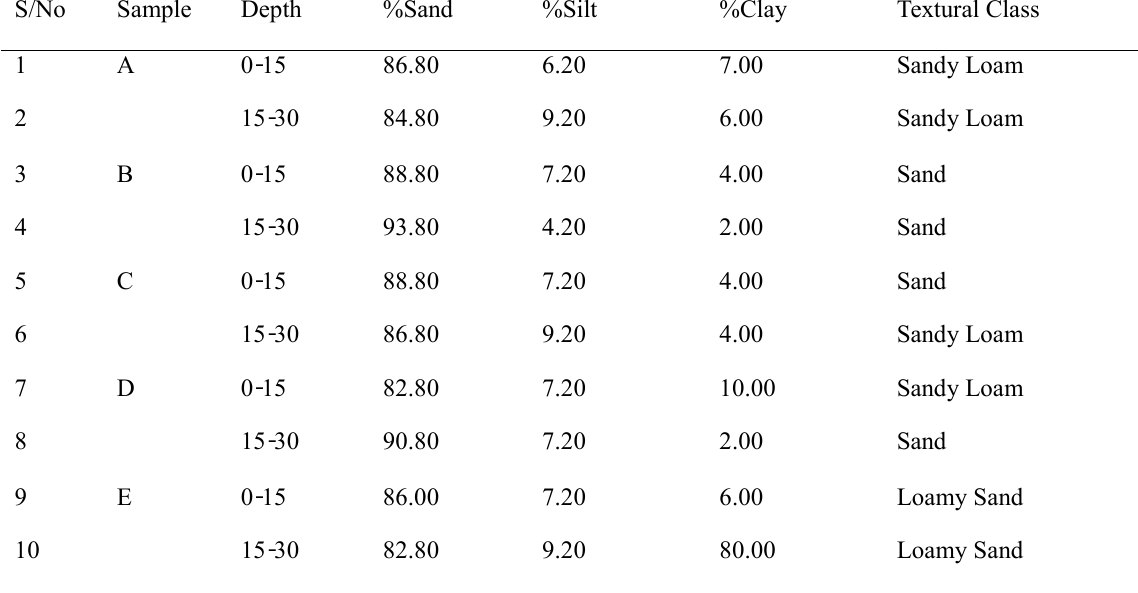
Results of particle size distribution analysis for the soil sample.